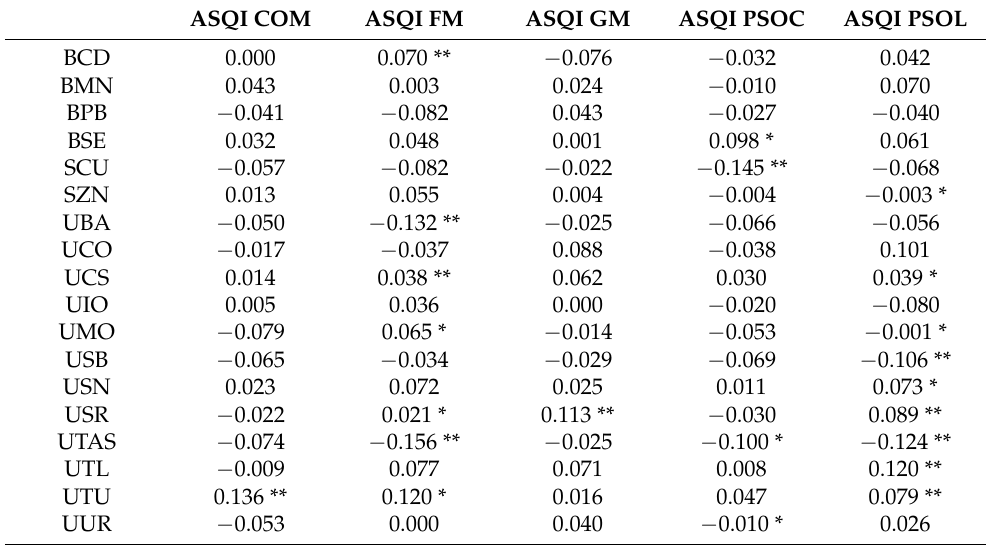
Table 3. Pearson’s R correlation between biomonitoring variables and age-adjusted ASQ:I